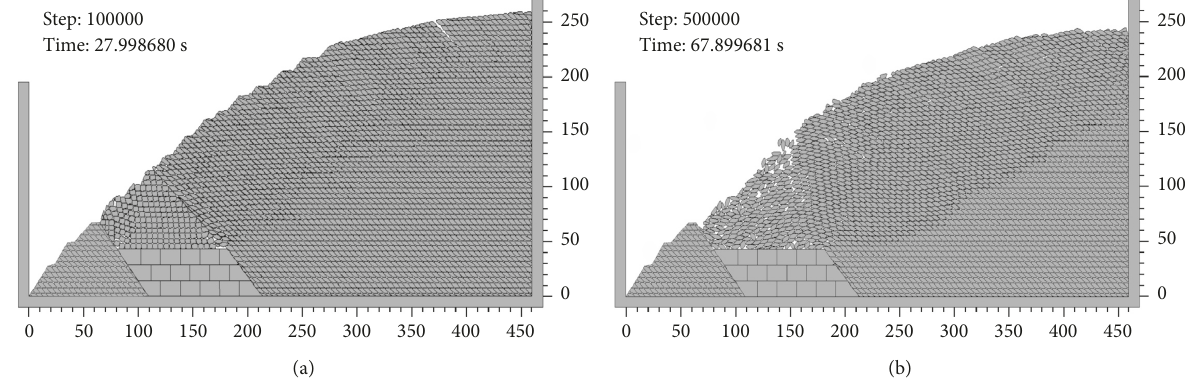
Figure 14: Slope instability after undercutting (a) and removing the caved ore (b).